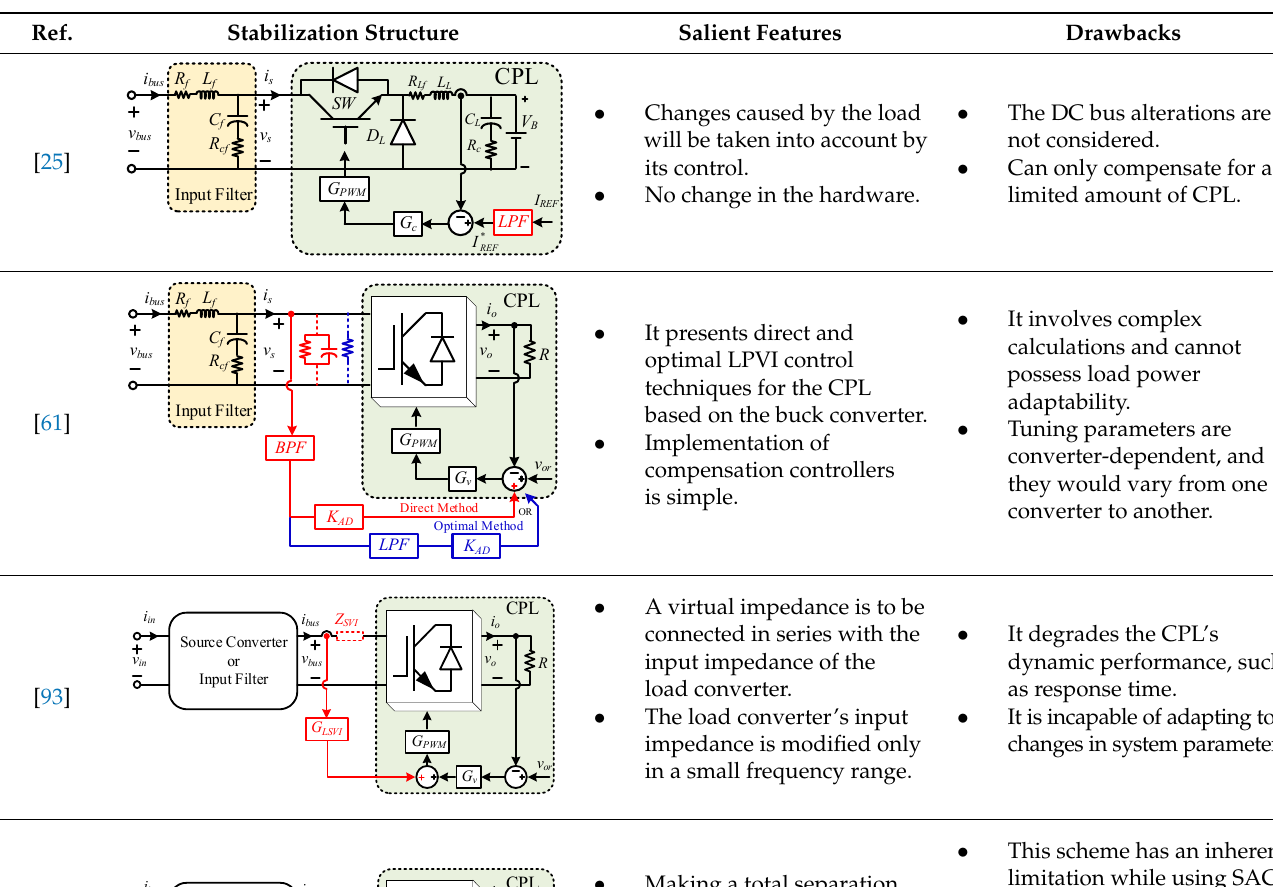
Table 2. Summary of CPL side active Table 2. Summary of CPL side active damping. Table 2. Summary of CPL side active damping. Table 2. Summary of CPL side active damping. Table 2. Summary of CPL side active damping. Table 2. Summary of CPL side active damping.